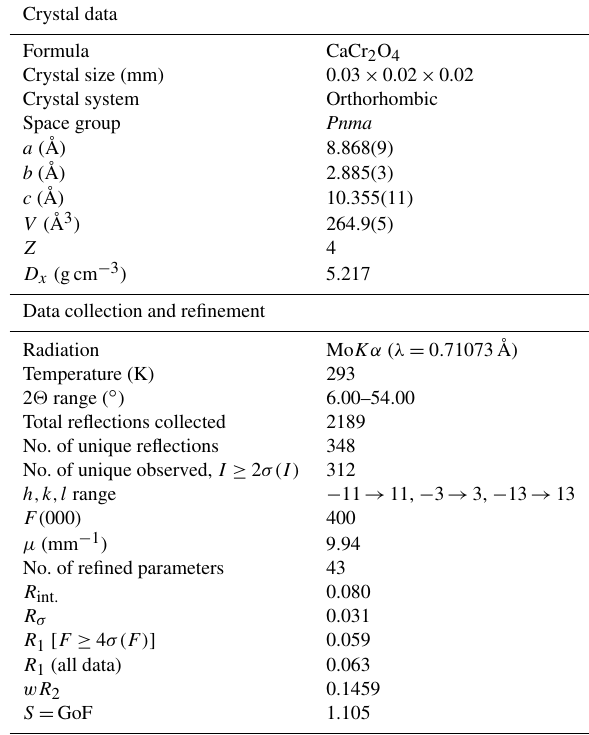
Table 4. Crystal parameters, data collection and structure refinement details for the holotype ellinaite (Hatrurim Basin,